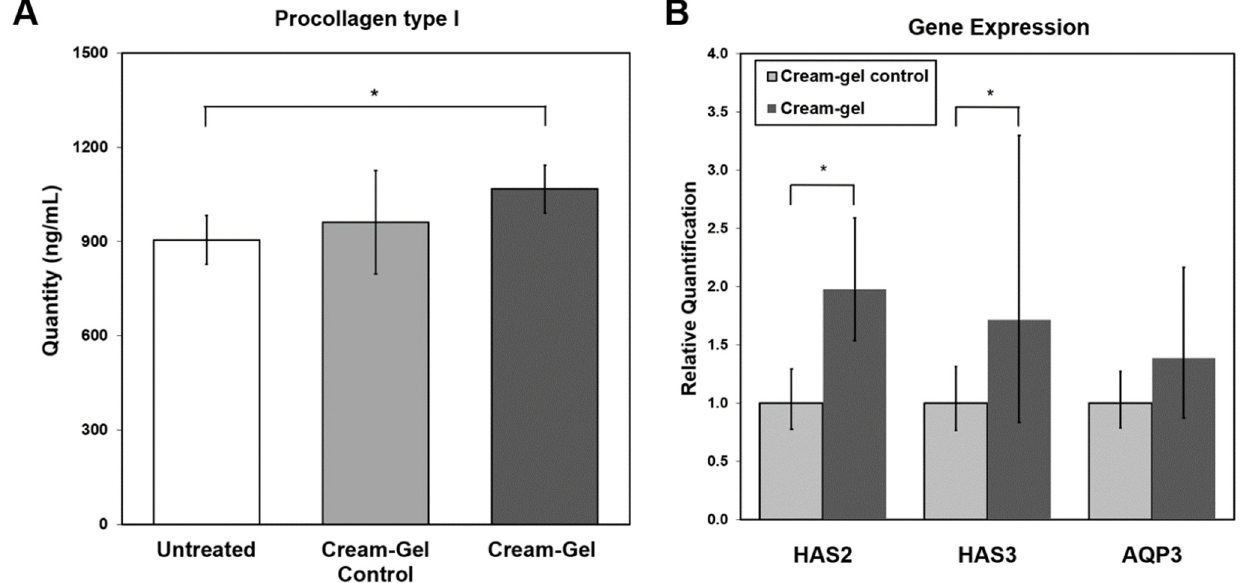
Figure 5. ( A ) Protein quantification of procollagen type I using ELISA in a reconstituted human skin tissue model after topical application of cream-gel product. The data presented are mean ± SEM. ( B ) Relative expression of related genes in skin hydration, HAS2 , HAS3 and AQP3 in a reconstituted human skin tissue model after topical application of cream-gel product. The data presented are RQ with RQmin and RQmax for the 95% confidence level, obtained from n = 4 samples for cream-gel control, and n = 5 for cream-gel treated skins and the untreated. Statistical comparisons with control samples were determined by t -test. P-value was corrected by Benjamini–Hochberg false discovery rate (* p < 0.05).